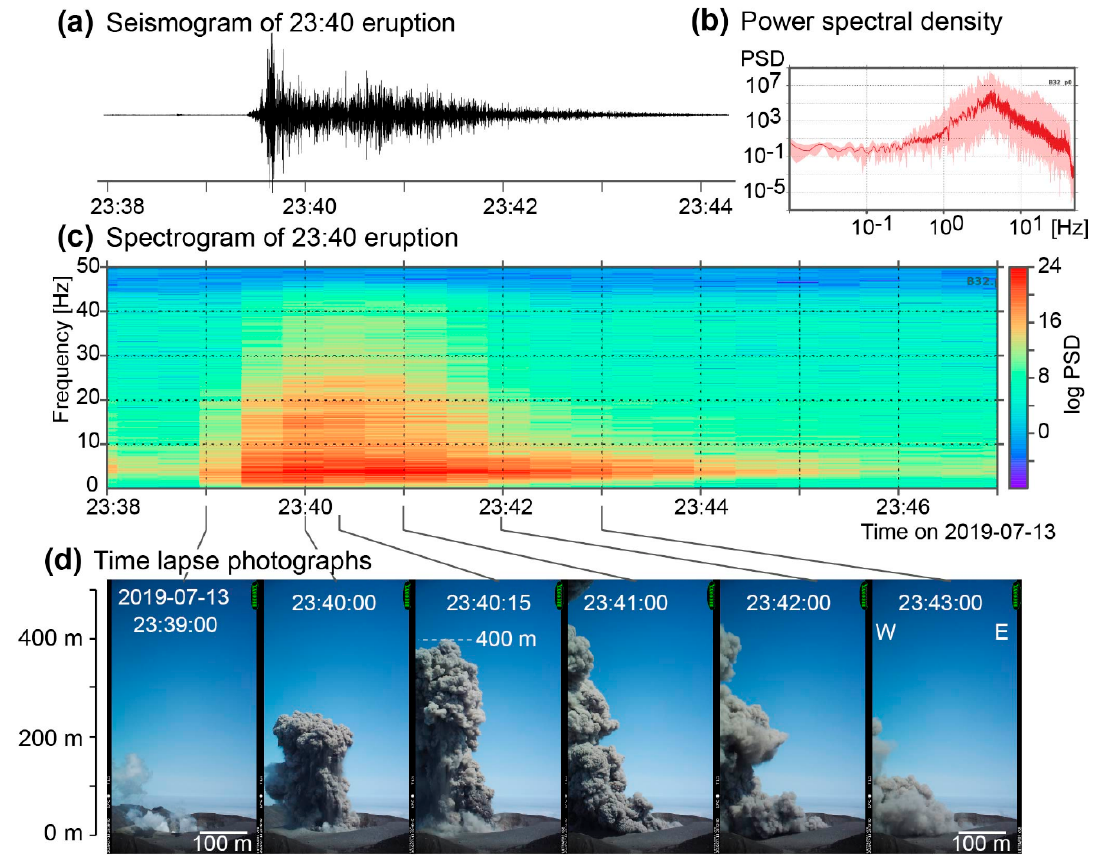
Figure 5. Geophone seismic records (radial component, E-W) and camera documentation of the 23:40 eruption event on 13 July 2019. ( a ) Seismogram of the 23:40 event, revealing a rapid emergence, two main amplitude peaks and a long coda. ( b ) The Power Spectral Density (PSD) indicates a peak at 3–4 Hz. ( c ) The spectrogram reveals a dominant lower frequency but also a 2-min lasting 10–40 Hz frequency episode associated with bomb and rock falls. ( d ) Photographs of the 23:40 event. Eruption height exceeded 400 m, airfall towards the west (left in north-looking camera view).